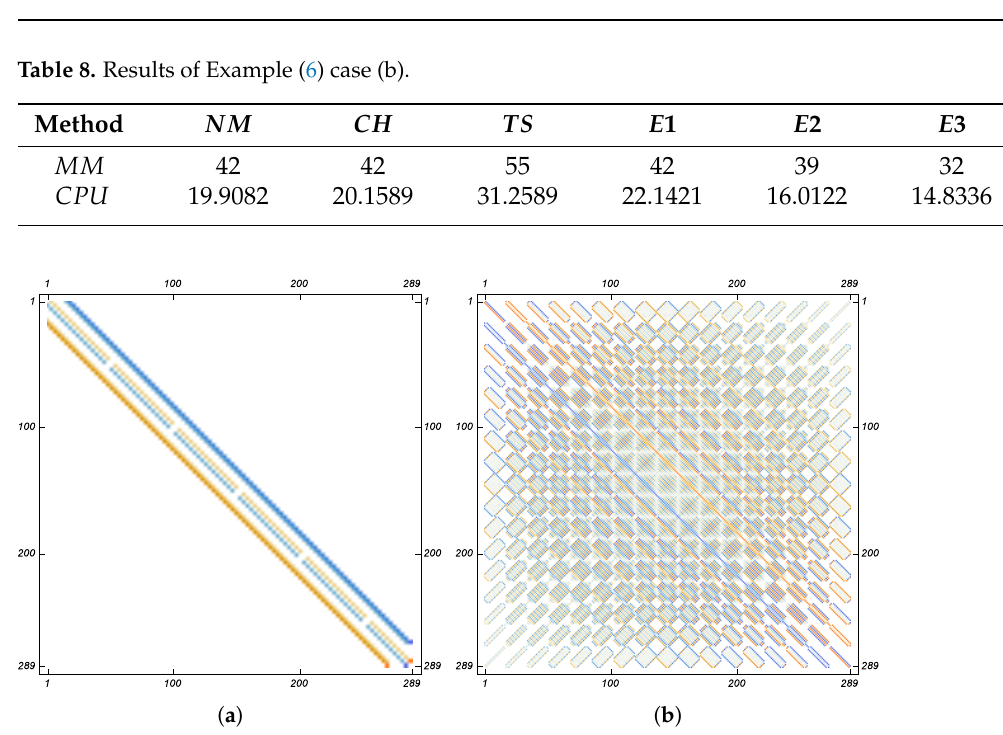
Figure 7. Representation of the ( a ) matrix and ( b ) inverse matrix for Example (6) case ( a ) when p = q = 17 and γ = 1.8.